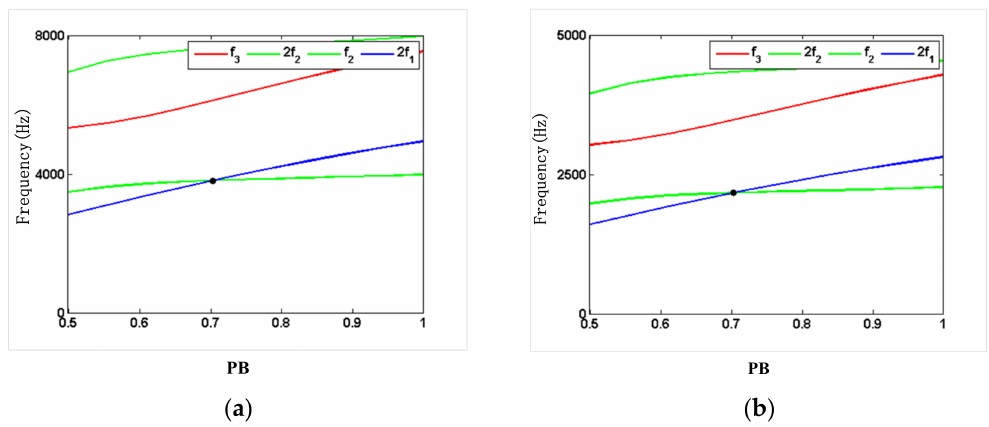
Figure 8. Internal resonant frequency of the resonator at a fixed-length ratio: ( a ) silicon; ( b )